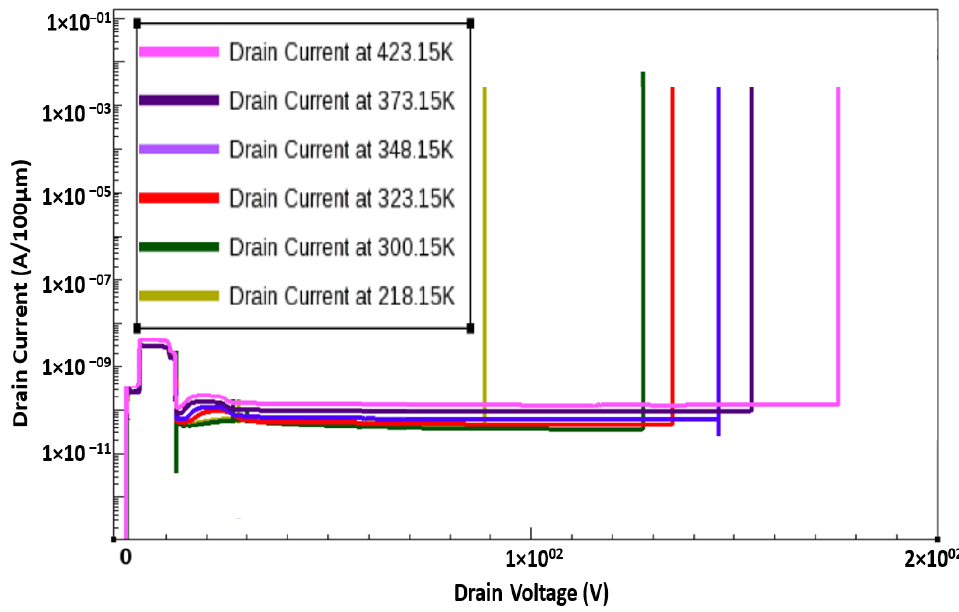
Figure 10. Temperature-dependent breakdown curve for a normally off AlGaN/GaN HEMT.